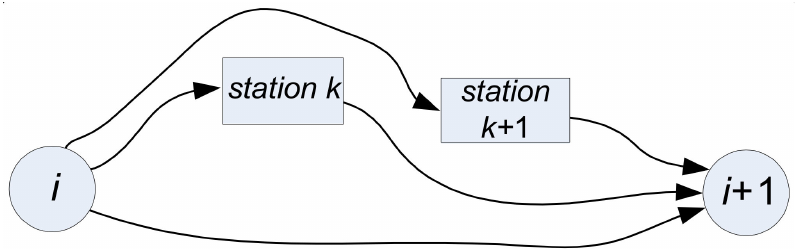
Figure 4. The solution. The potential road section is substituted with two potential road sections as described in Case